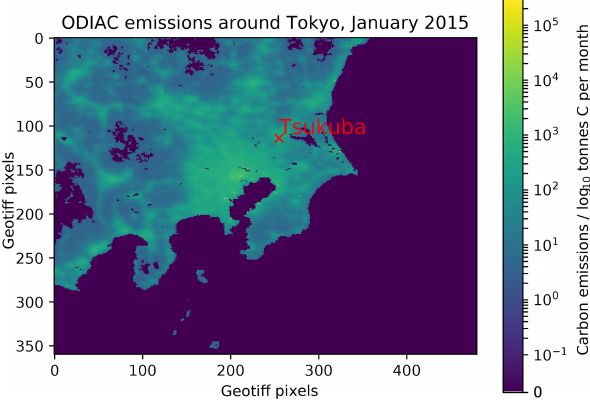
Figure 6. ODIAC carbon emissions per 1km × 1km pixel for Jan- uary 2015 in log 10 scale. This graph is created directly from the 1km × 1km ODIAC dataset (Oda and Maksyutov, 2011, 2016) to visualize its structure. The model emissions are shown for the area visualized in the middle panel of Fig. 3. The unit is metric tonnes of carbon per cell and month as described in the README file at http://db.cger.nies.go.jp/dataset/ODIAC/readme/ readme_2016_20170202.txt (last access: 21 May 2020).